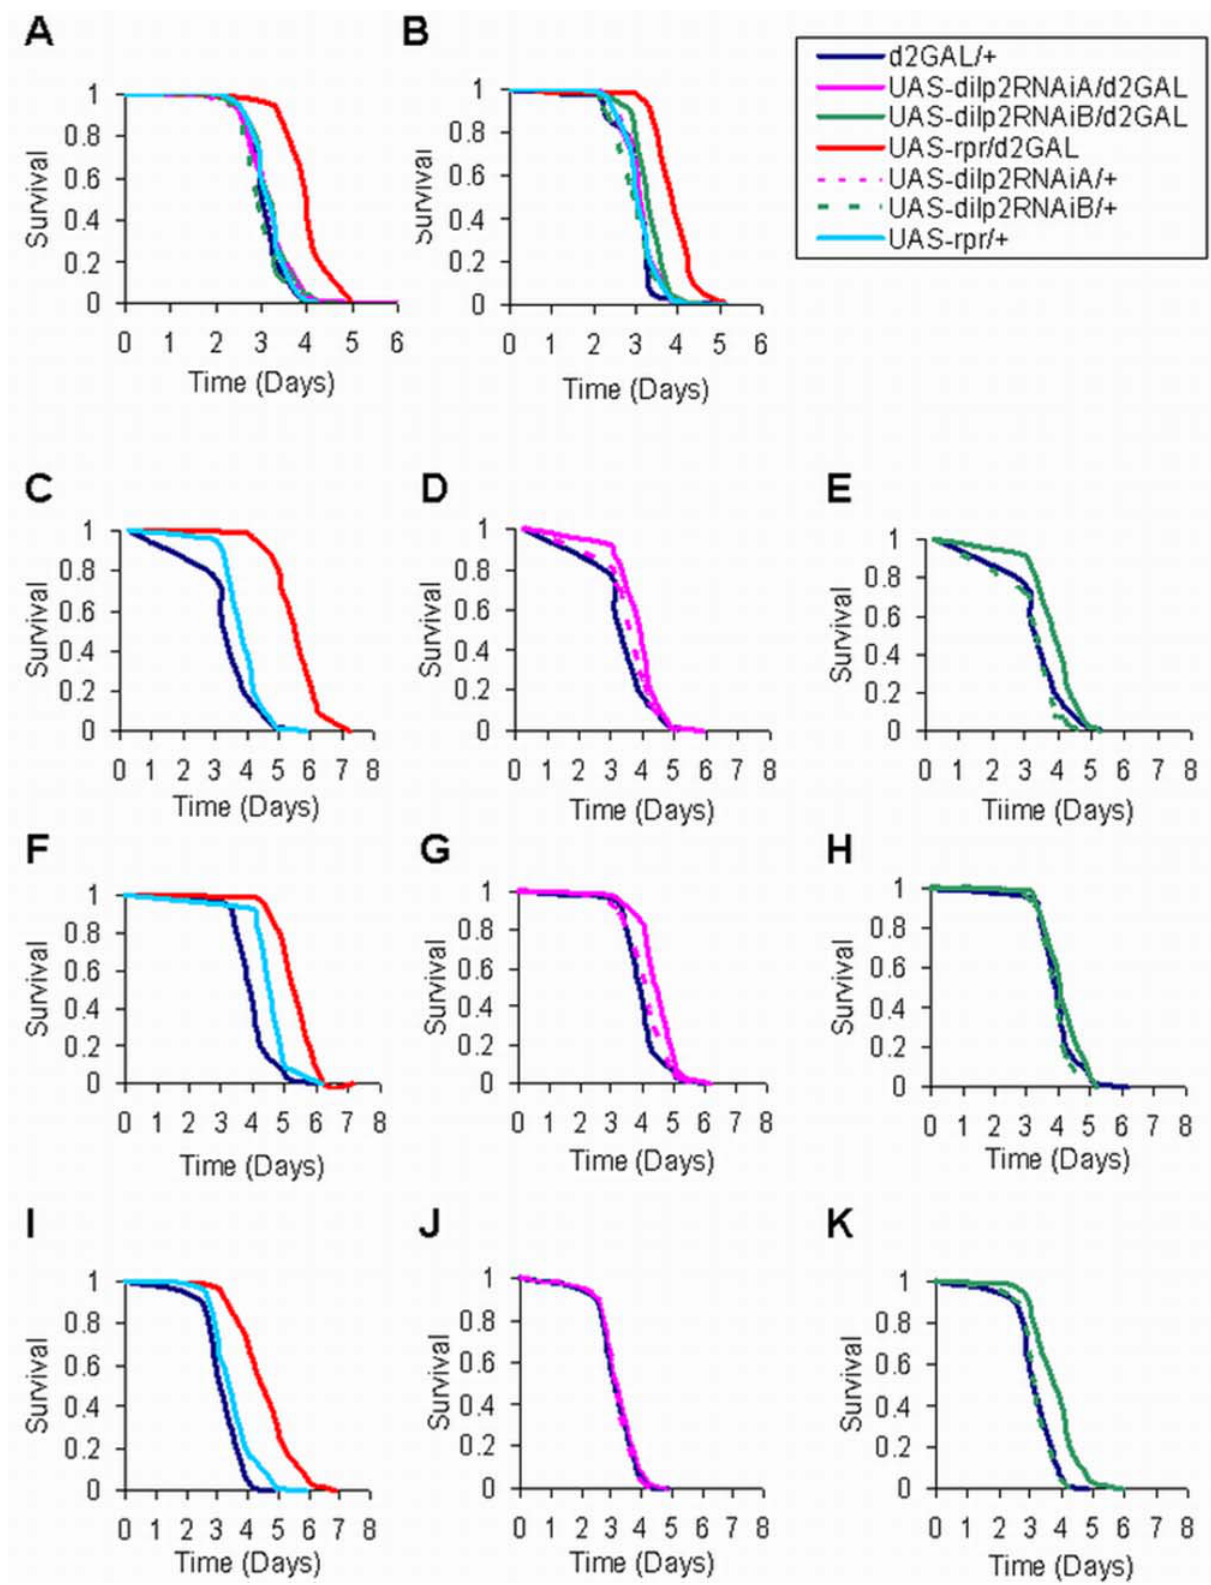
Figure 3. Survival of dilp2RNAi/d2GAL female flies under oxidative stress and starvation. Survival curves, median lifespans, percentage increase compared to control, and sample sizes of 7 day old mated females are as follows: (A) Experiment 1 on 5% H 2 O 2 . Median lifespans (in days) of: UAS-rpr/d2GAL=4.04, N=104, (34% increase over d2GAL/ + control, P , 0.0001); UAS-dilp2RNAiA/d2GAL=3.25, N=102; UAS-dilp2RNAiA/ + =3.25,